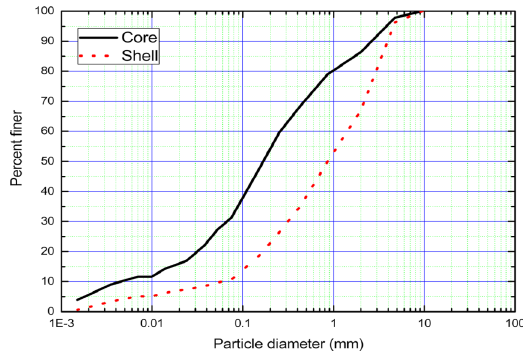
Fig. 2. Particle size accumulation curve for each material